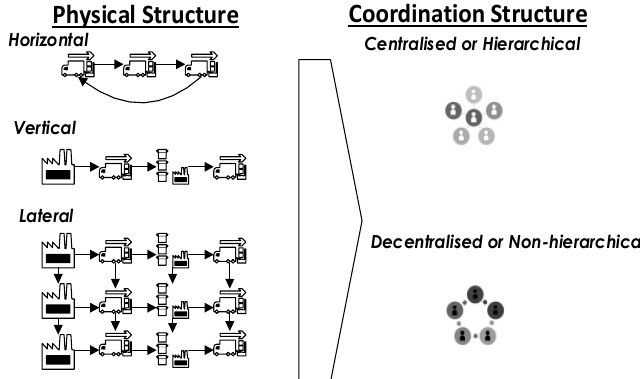
Figure 1. Forms of collaboration from physical and coordination structure perspectives.